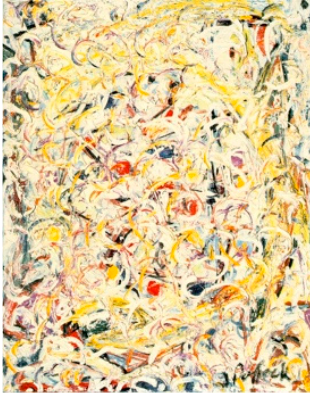
Figure 15. Jackson Pollock, Shimmering Substance , ca. 1946. Oil on canvas, 30 1/8 × 24 1/4 in. (76.3 × 61.6 cm). Collection Museum of Modern Art, New York. Mr. and Mrs. Albert Lewin and Mrs. Sam New York.